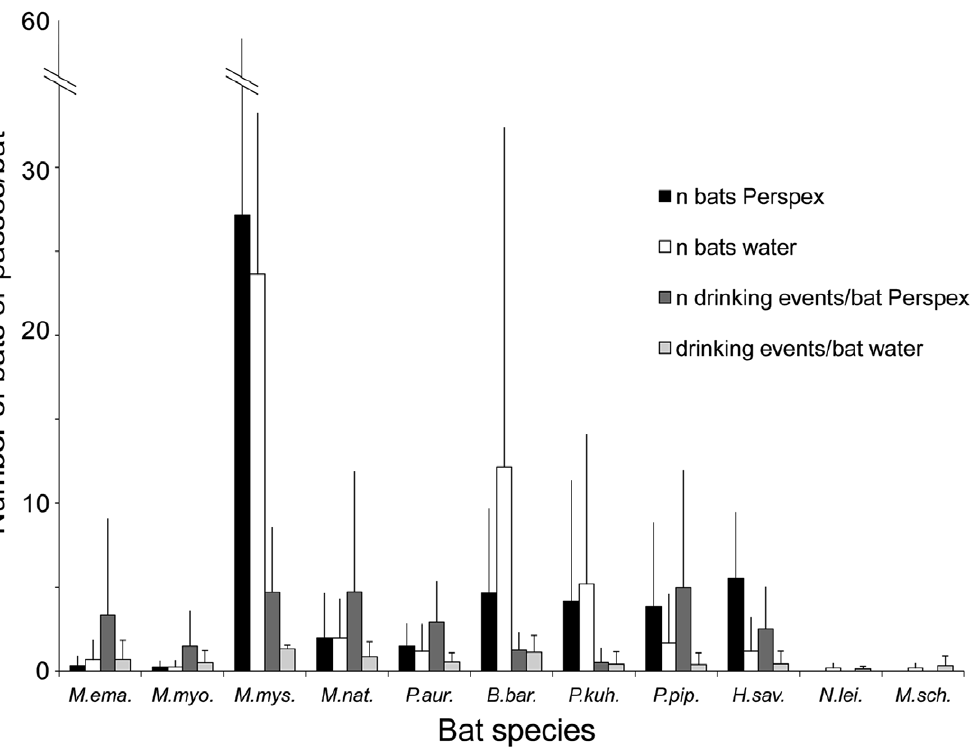
Figure 1. Mean numbers of bats and mean numbers of drinking attempts per bat on Perspex vs. water categorized by species. Error bars show the standard deviation. M. ema. = Myotis emarginatus , M.myo = Myotis myotis , M.mys. = Myotis mystacinus M.nat. = Myotis nattereri , P.aur. = Plecotus auritus , B.bar. = Barbastella barbastellus , P.kuh. = Pipistrellus kuhlii , P.pip. = Pipistrellus pipistrellus , H.sav. = Hypsugo savii , N.lei. = Nyctalus leisleri , M.sch. = Miniopterus schreibersii.